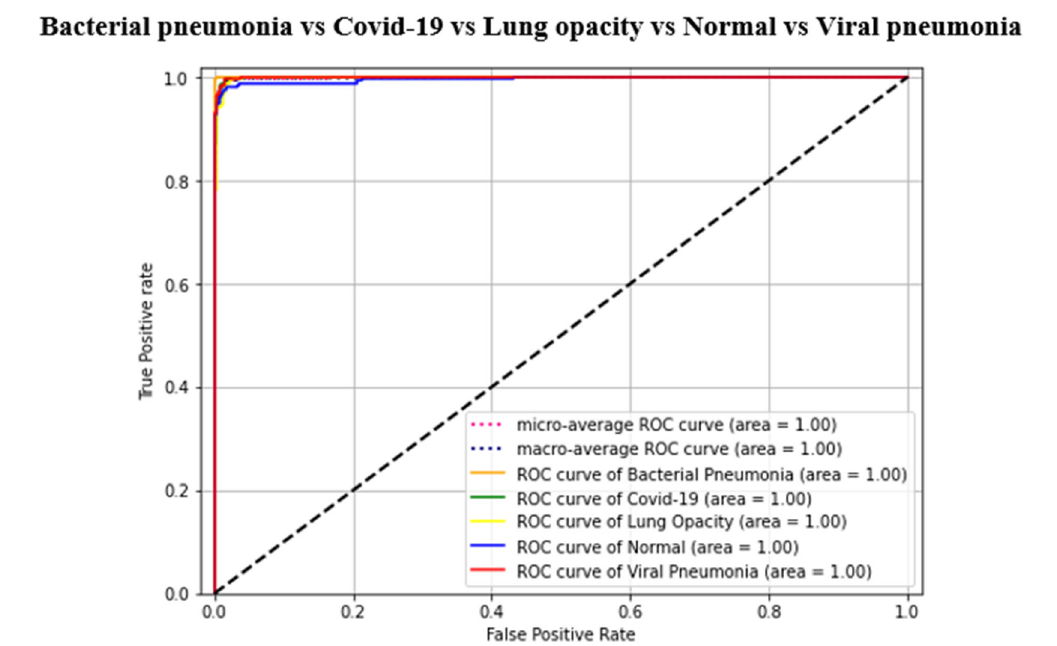
Figure 7. AUC ‐ ROC curves of all classification tasks (5th fold). Figure 7. AUC-ROC curves of all classification tasks (5th fold). Table 6. Running time for all classification tasks by FirecovNet in 50 epochs. Table 6. Running time for all classification tasks by FirecovNet in 50 epochs. Task Train (for Each Epoch) Test (for All of the Test Data) Task Train (for Each Epoch) Test (for All of the Test Data) BCNV 22 s 2